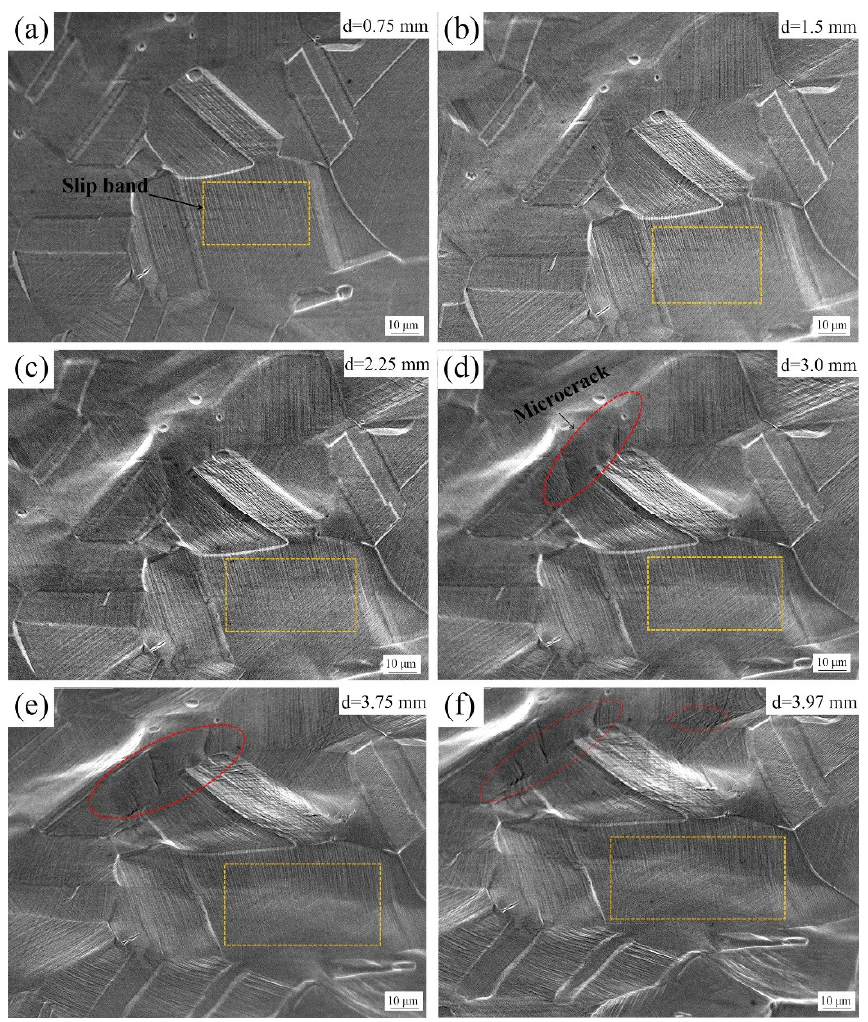
Figure 13. Slip bands and microcrack morphology transition of steel 1# with different tensile dis- placements.